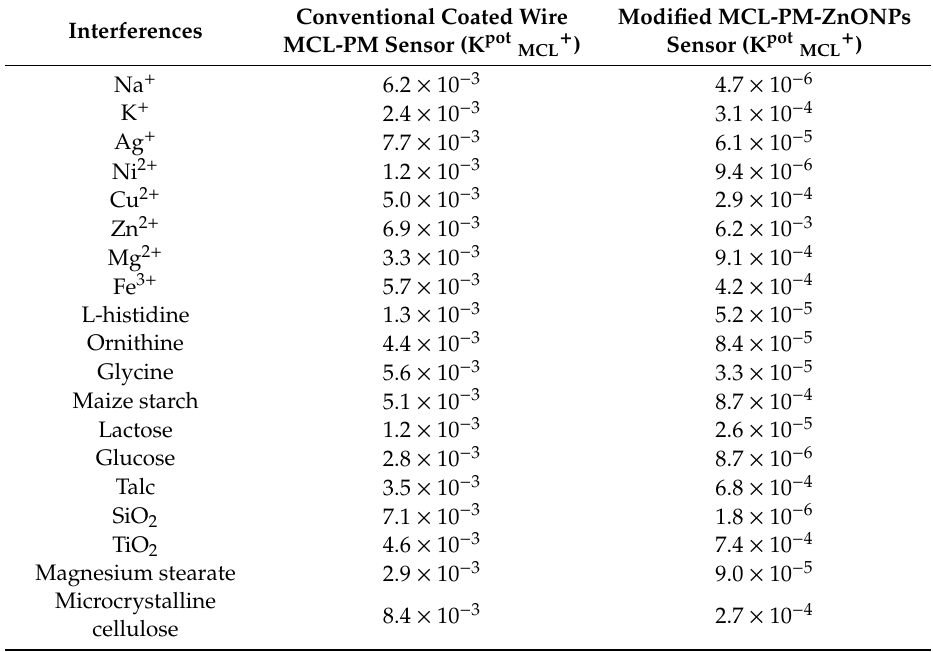
Table 2. Selectivity coefficient (K Pot MCL+ ) of conventional coated wire MCL-PM and modified MCL-